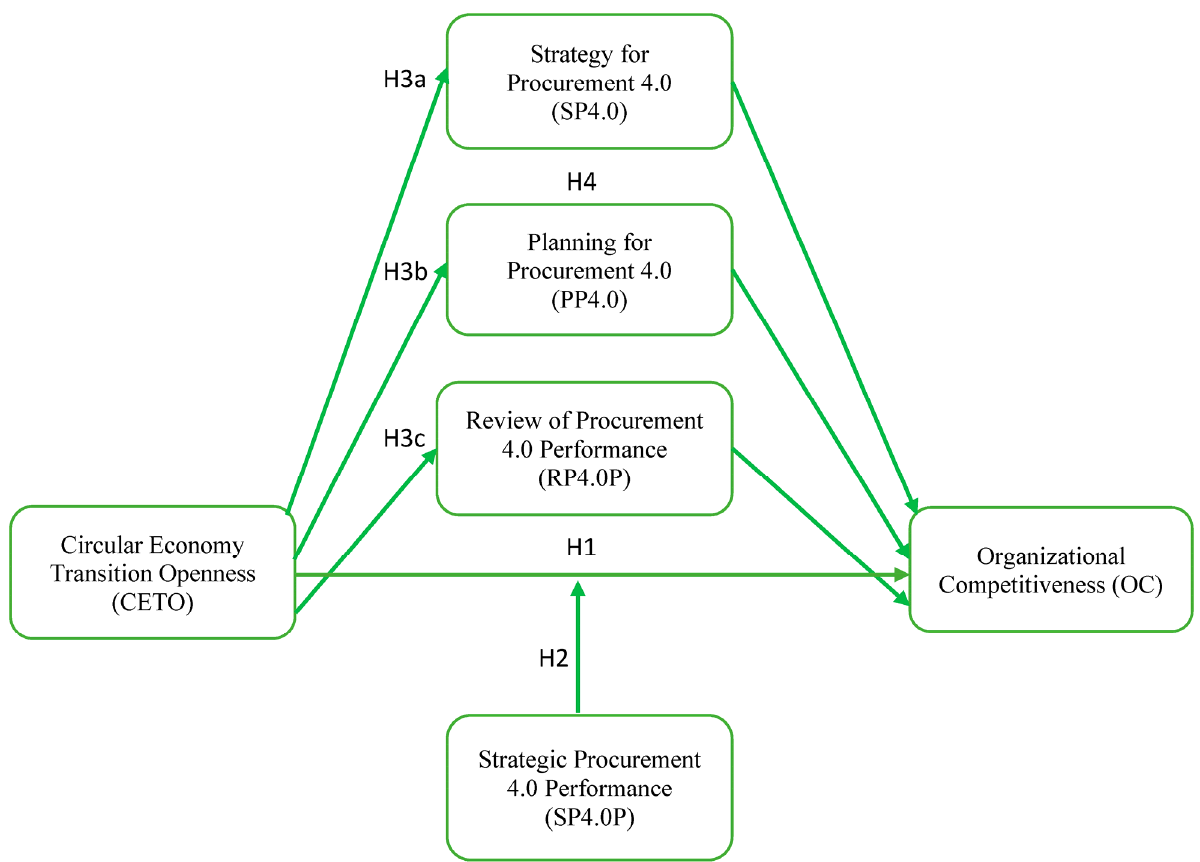
Figure 1. Conceptual